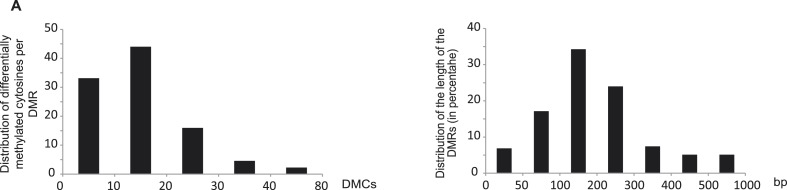
Characteristics of the root PSI DMRs.